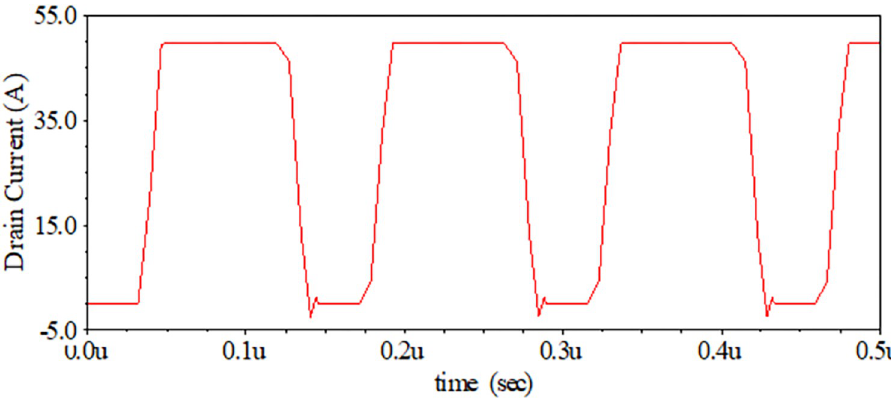
Fig 11. Transient analysis of proposed sic nmos for pulse ( μ = micro).